Question: Briefly state, in one sentence, what is plotted here.
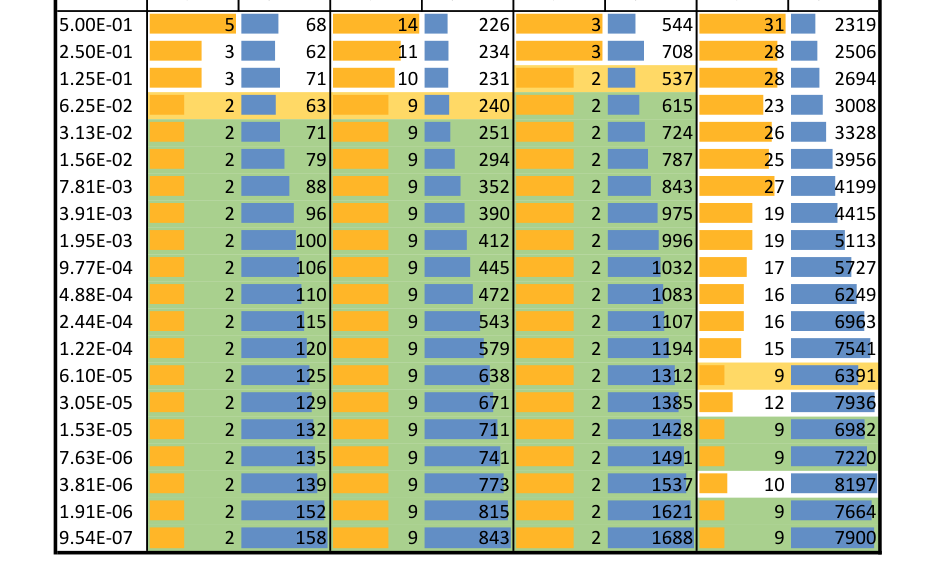
Answer: Comparison of inV-cycle methods with CG as the coarsest-level solver with various choices of relative residual tolerance τ. The bright yellow and green color highlight variants that converge in the same number of V-cycles as the variant with MATLAB backslash operator on the coarsest-level. The bright yellow variants achieve this in the least total number of CG iterations on the coarsest-level.